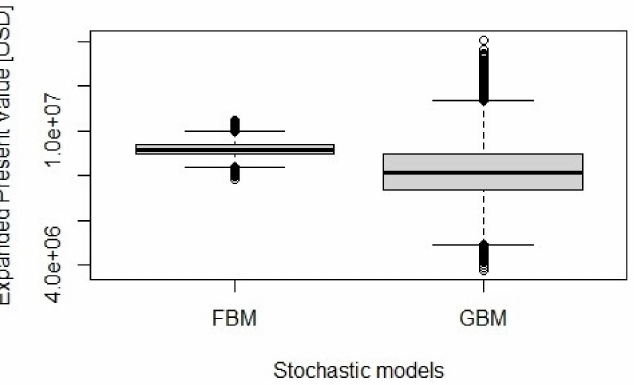
Figure 3. Boxplot of the expanded present value for stochastic models fractional Brownian motion and geometric Brownian motion, representing the difference between the